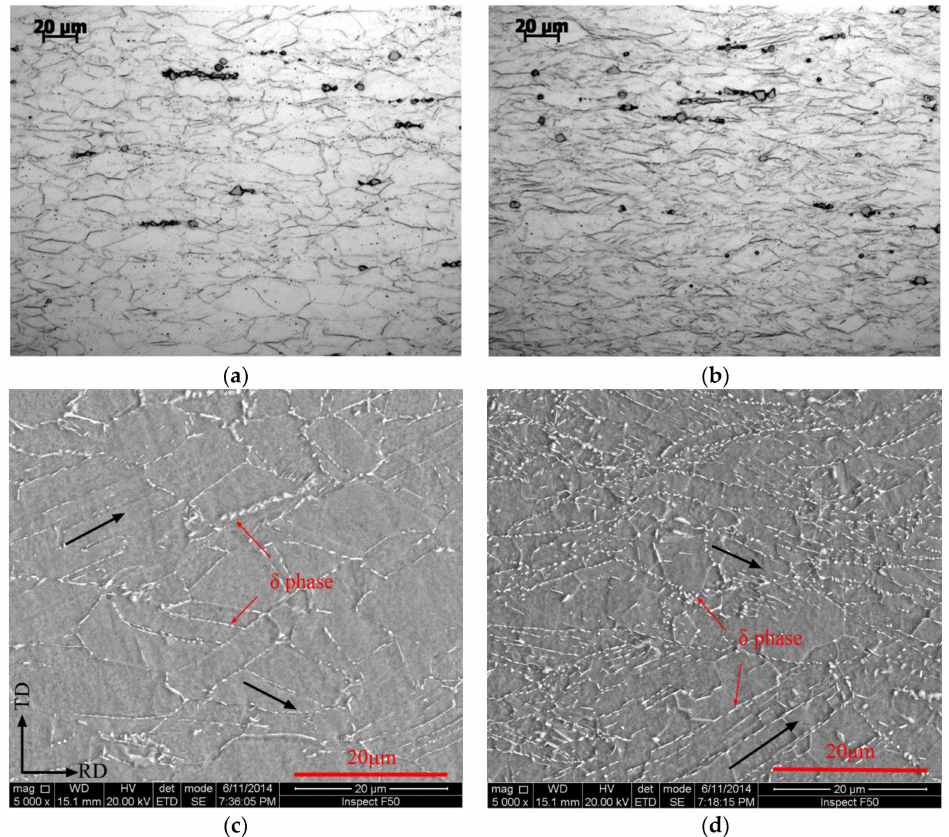
Figure 2. Microstructure evolution under different rolling reductions (980 ˝ C 1 h) ( a ) ε = 30% ( b ) ε = 50% after cold rolling ( c ) ε = 30% ( d ) ε = 50% after solid